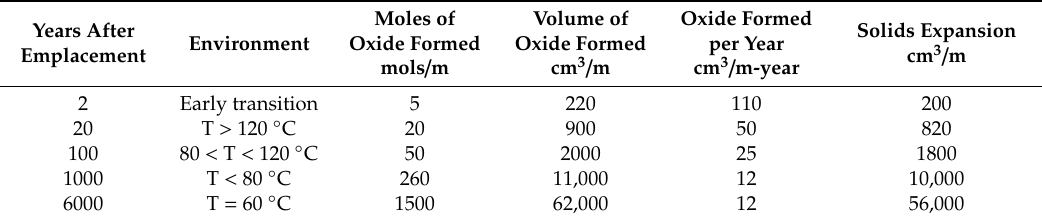
Table 9. Oxide formation from corrosion per meter of L80 Steel per side per meter of